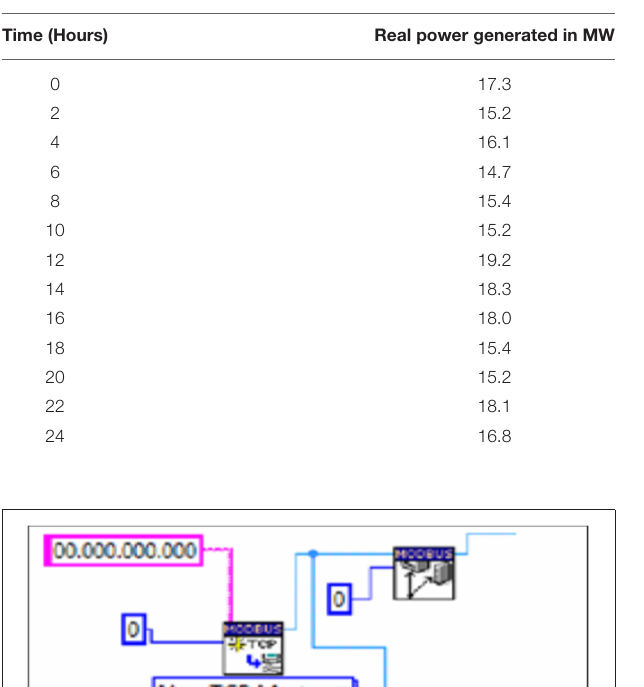
TABLE 1 | Real power output for 24h.